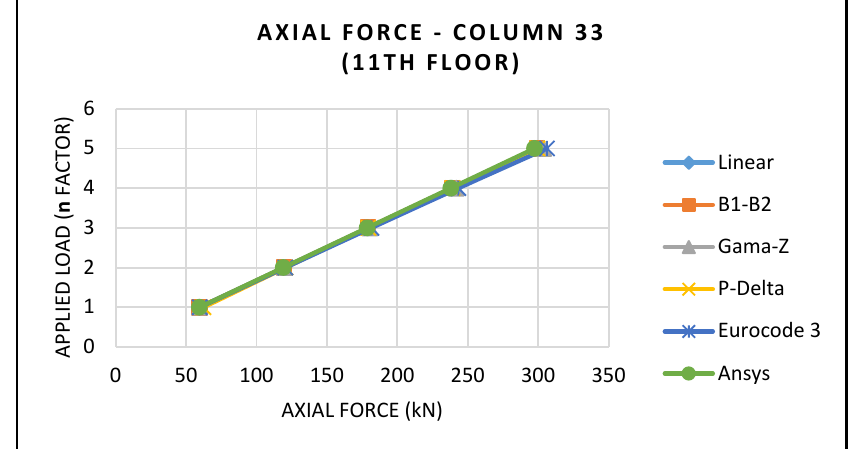
Figure 12 - Load - axial force relationship for column 33. Source: Authors